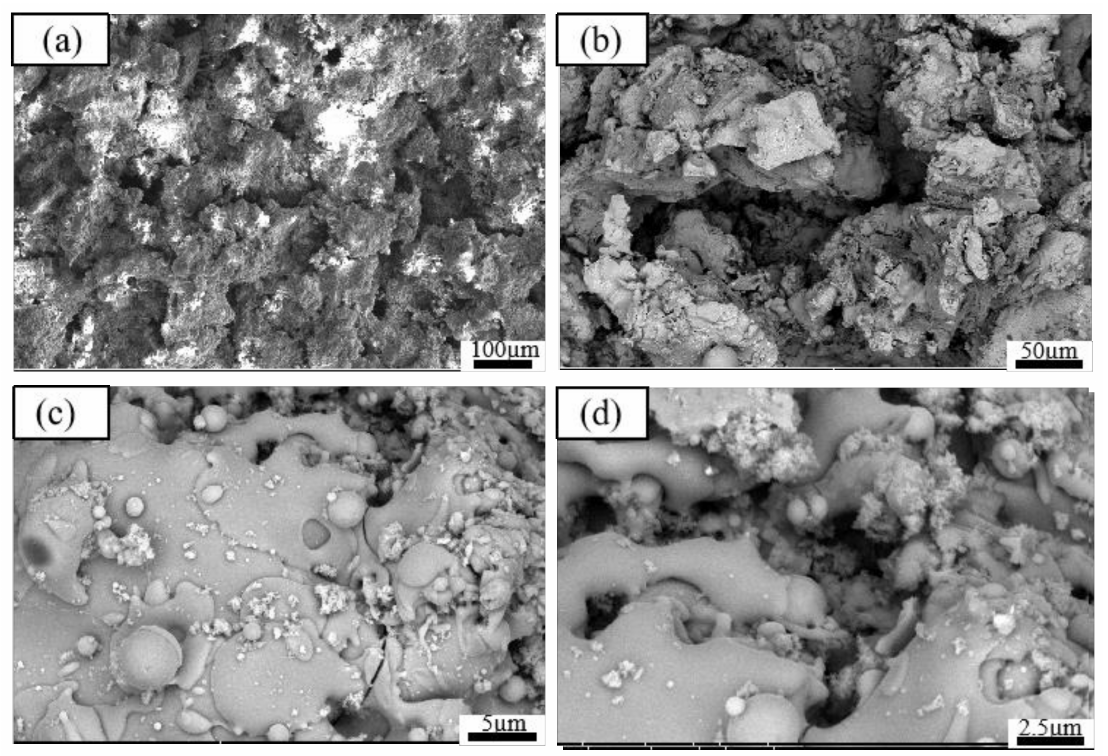
Figure 7. SEM images at different magnifications of the surface of Ti/Ti/HA coating: ( a ) × 200,